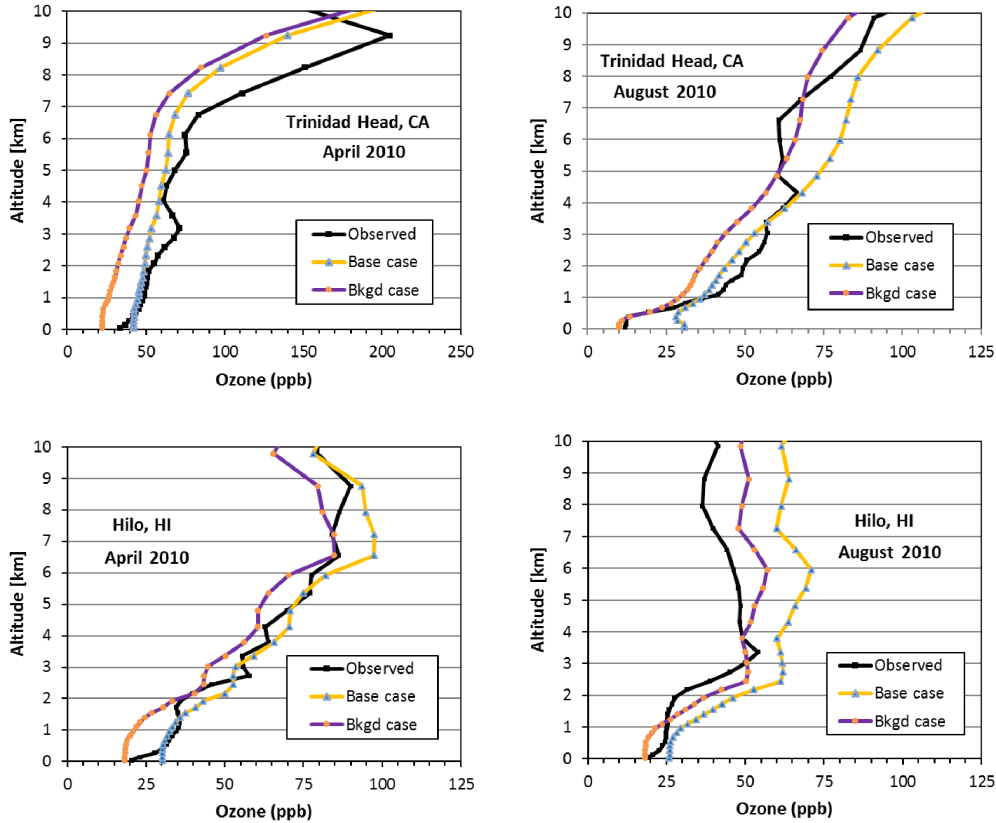
Figure 3. Comparison of GEOS-Chem vertical O 3 profiles for the base and background cases in April and August to ozonesonde measure- ments at a site on the west of the continental US (Trinidad Head) and west of the CAMx domain (Hilo). Monthly averages are